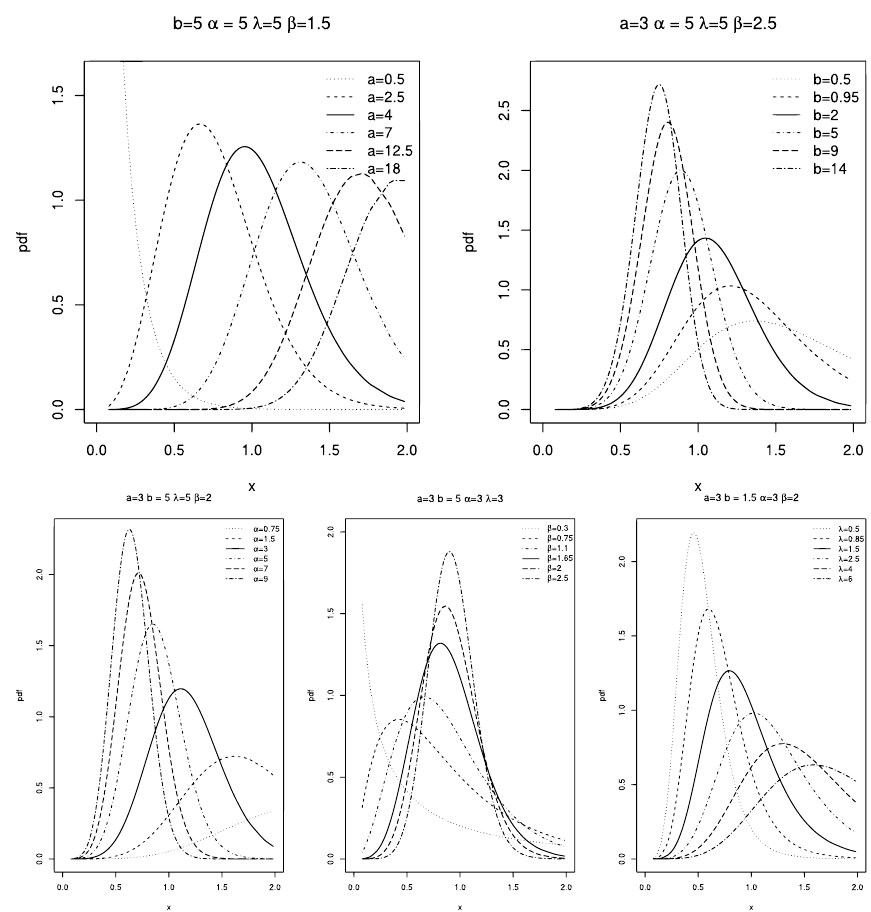
Figure 1. Curves of the pdf of the KPL distribution at different parameter